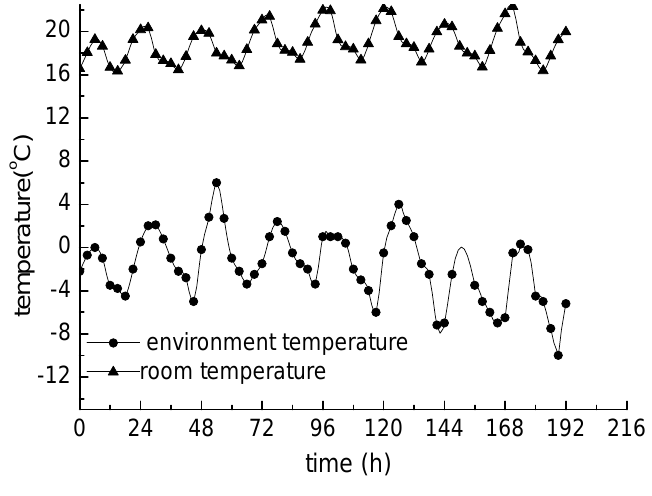
Figure 10. Room temperature and environment temperature during